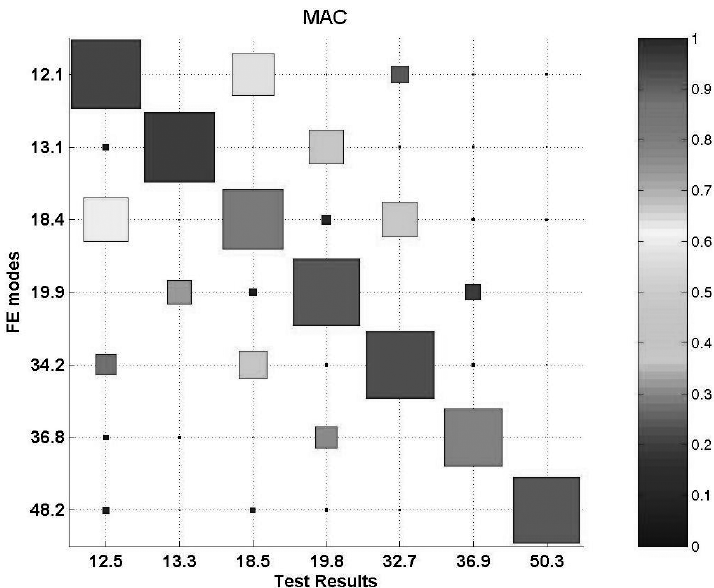
Fig. 9. MAC table after offset correction and